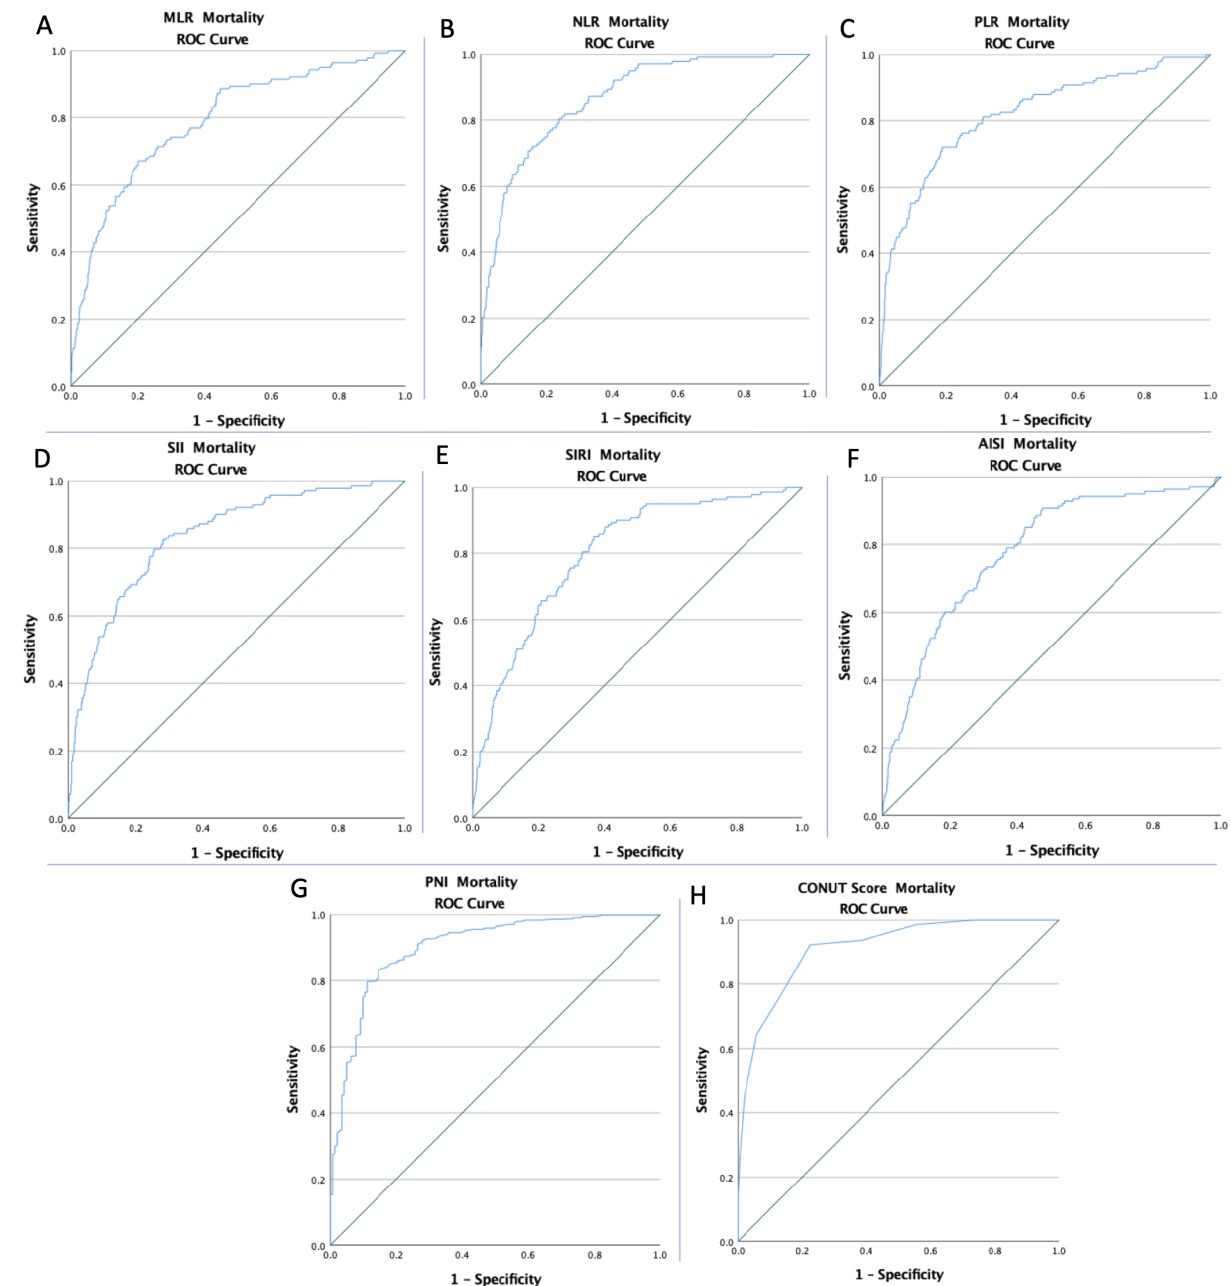
Figure 3 . The ROC curve analysis concerning mortality ( A ) for the MLR (AUC: 0.794; p < 0.0001), ( B ) for the NLR (AUC: 0.868; p < 0.0001), ( C ) for the PLR (AUC: 0.819; p < 0.0001), ( D ) for the SII (AUC: 0.836; p < 0.0001), ( E ) for the SIRI (AUC: 0.801; p < 0.0001), ( F ) for the AISI (AUC: 0.780; p < 0.0001), ( G ) for the PNI (AUC: 0.903; p < 0.0001), and ( H ) for the CONUT Score (AUC: 0.913; p < 0.0001).